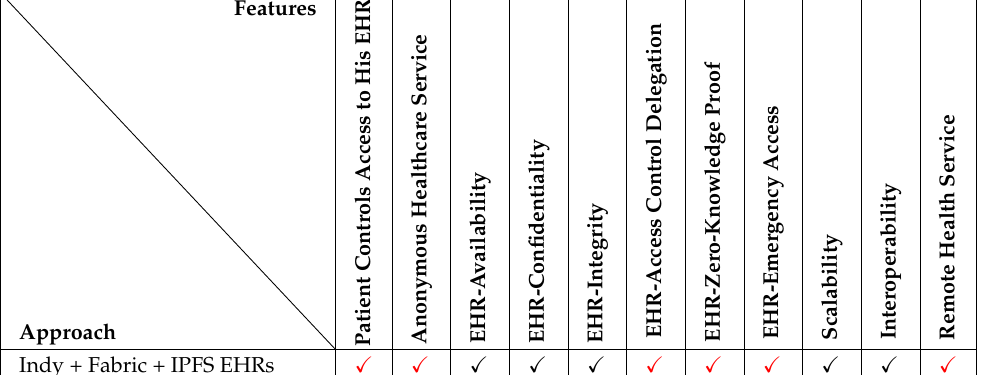
Table 10. Features of the architecture based on Indy, Fabric and IPFS. Features